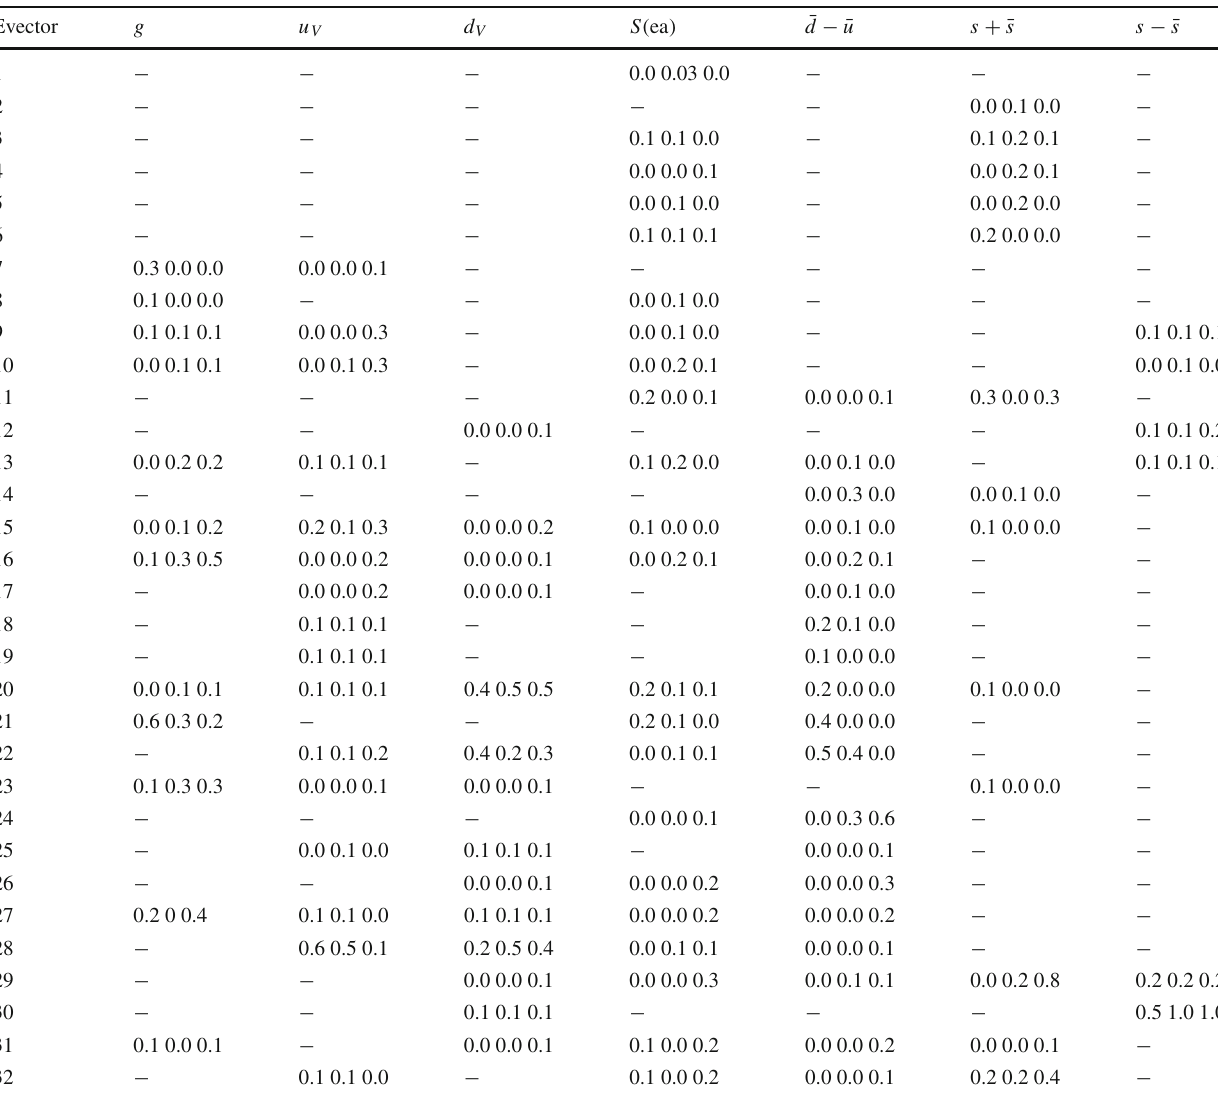
Table 11 The fractional contribution to the total uncertainty for the g , u V ,... input distributions in the small x ( x < 0 . 01 ), medium x ( 0 . 01 < x < 0 . 1 ) and high x ( x > 0 . 1 ) regions, respectively, arising from eigenvector k in the NNLO global